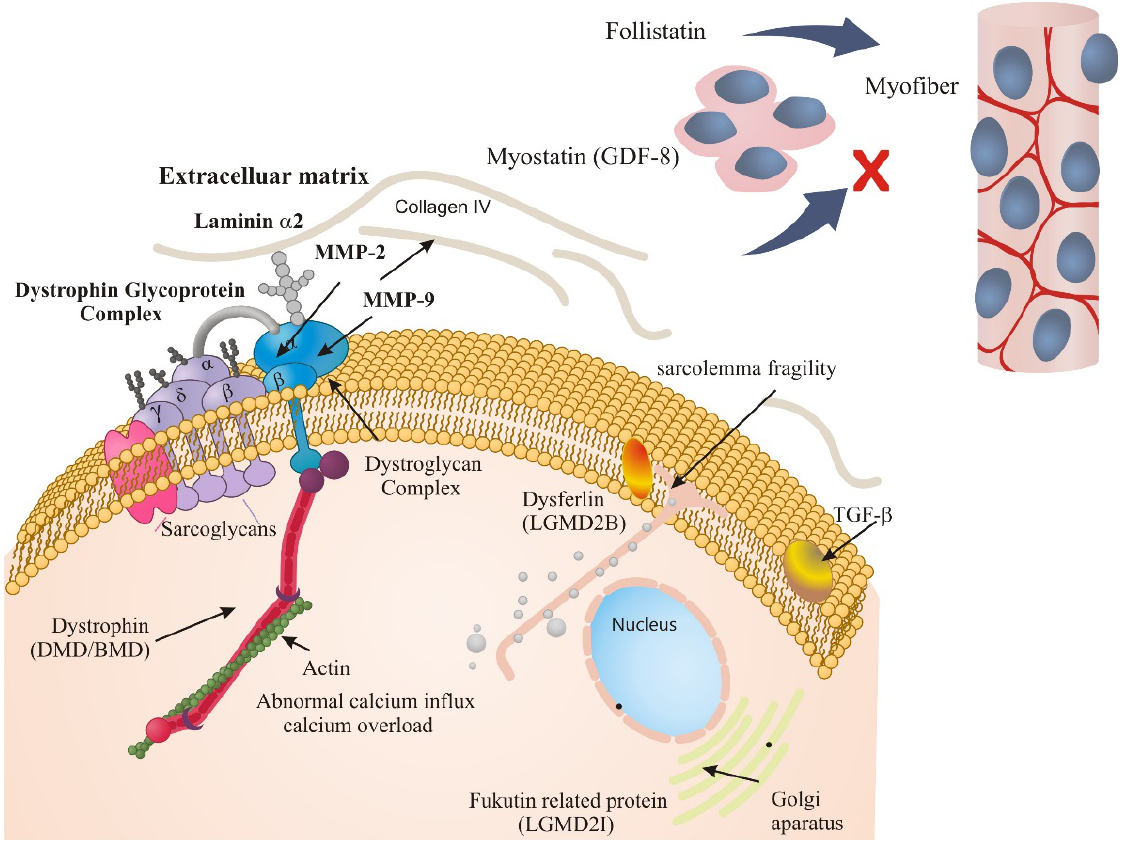
Figure 1. Representation of the dystrophin glycoprotein complex. Dystrophin is depicted in red, while other proteins that cause LGMD2 and LGMD2I such as dysferlin and fukutin-related protein, respectively, are also shown. In the extracellular matrix the cleavage of dytroglycan complex as a target of MMP-2 and MMP9 is shown. As the disease progresses, satellite cell activation occurs to repair damaged muscle, yet nevertheless myofiber differentiation is prevented by GDF-8 and the action of GDF-8 is simultaneously modulated by its inhibitory counterpart